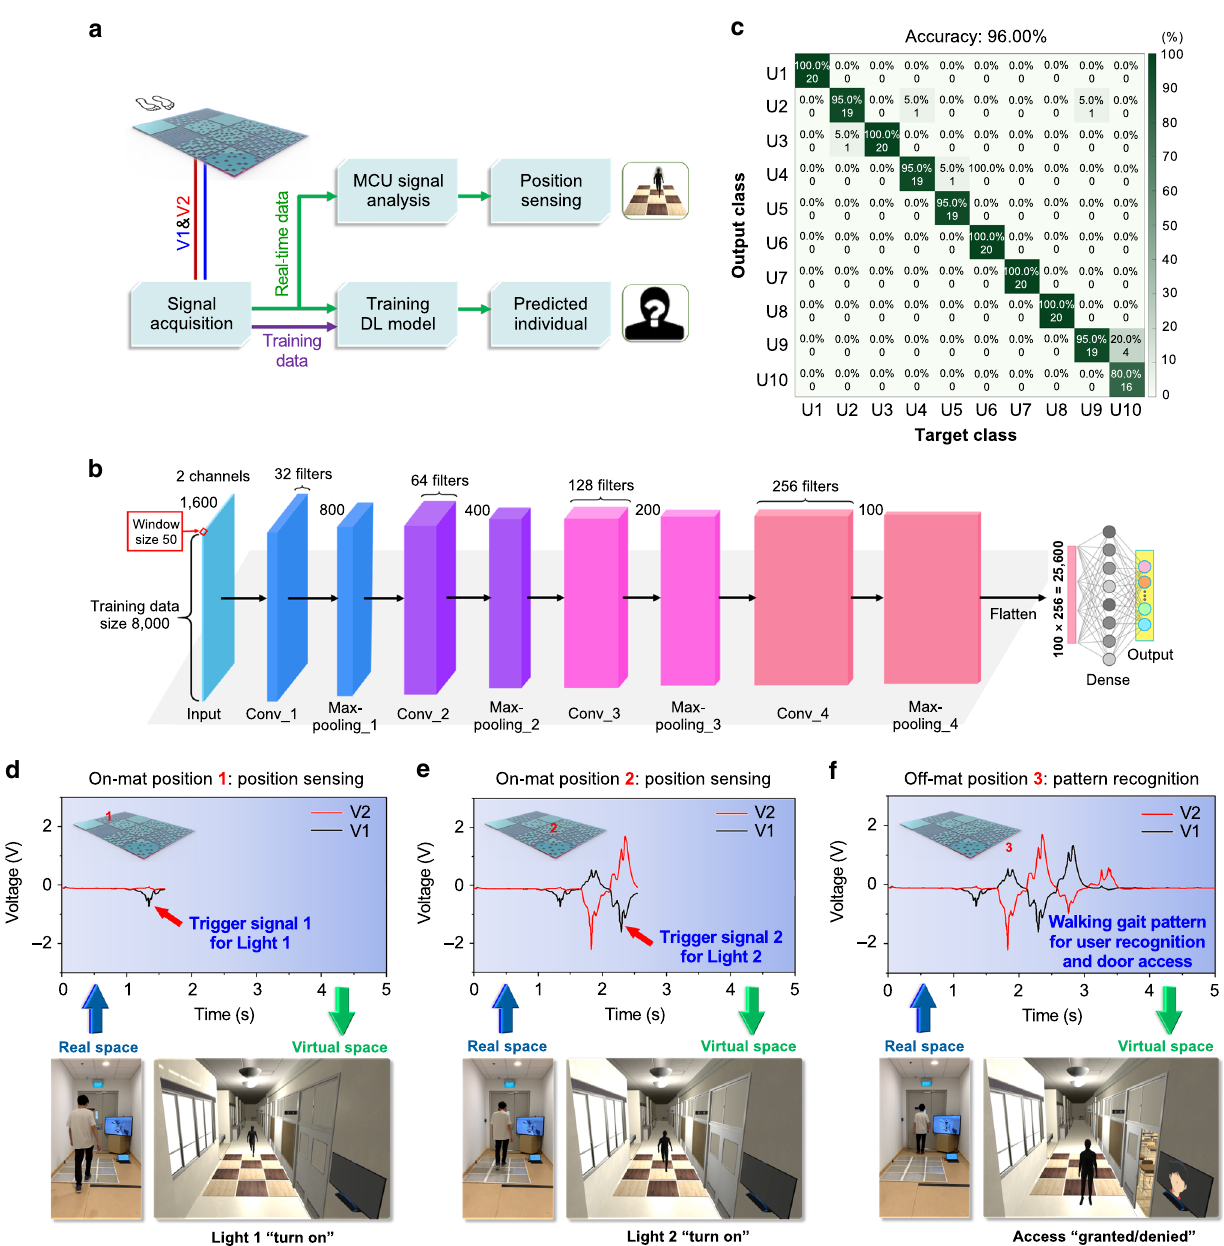
Fig. 5 Smart fl oor monitoring system with integrated deep learning-assisted data analytics. a The overall structure and data fl ow of the smart fl oor monitoring system for real-time position sensing and individual recognition in smart building/home applications. b The detailed structure of the convolutional neural network (CNN) training model. c The confusion matrix for individual recognition of 10 different users, showing a high accuracy of 96%. d – f Demonstration of the different stages in real-time position sensing and individual recognition, where a person is walking in the real space while his digital twin is controlled to walk in the virtual space correspondingly: d At Position 1, the fi rst negative peak is detected and used to turn on Light 1; e At Position 2, the third negative peak is detected and used to turn on Light 2; f At Position 3, the full walking signal is detected and analyzed in CNN model for individual prediction ( “ valid/invalid user ” ) and door access control ( “ granted/denied ”